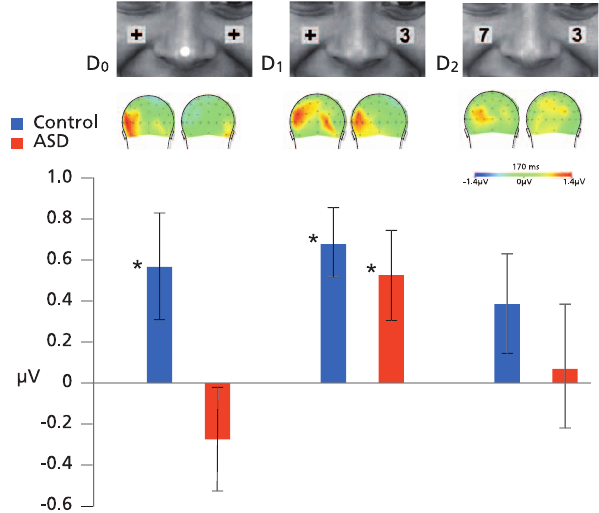
Figure 3. Occipital-temporal N170 amplitudes. Left N170 amplitude differences ( 6 SE) between stimulus conditions (FF - FH) show a lack of higher-order MSI in the D 0 condition for ASD individuals, while both groups show such an effect in the D 1 condition (*=p , .05).